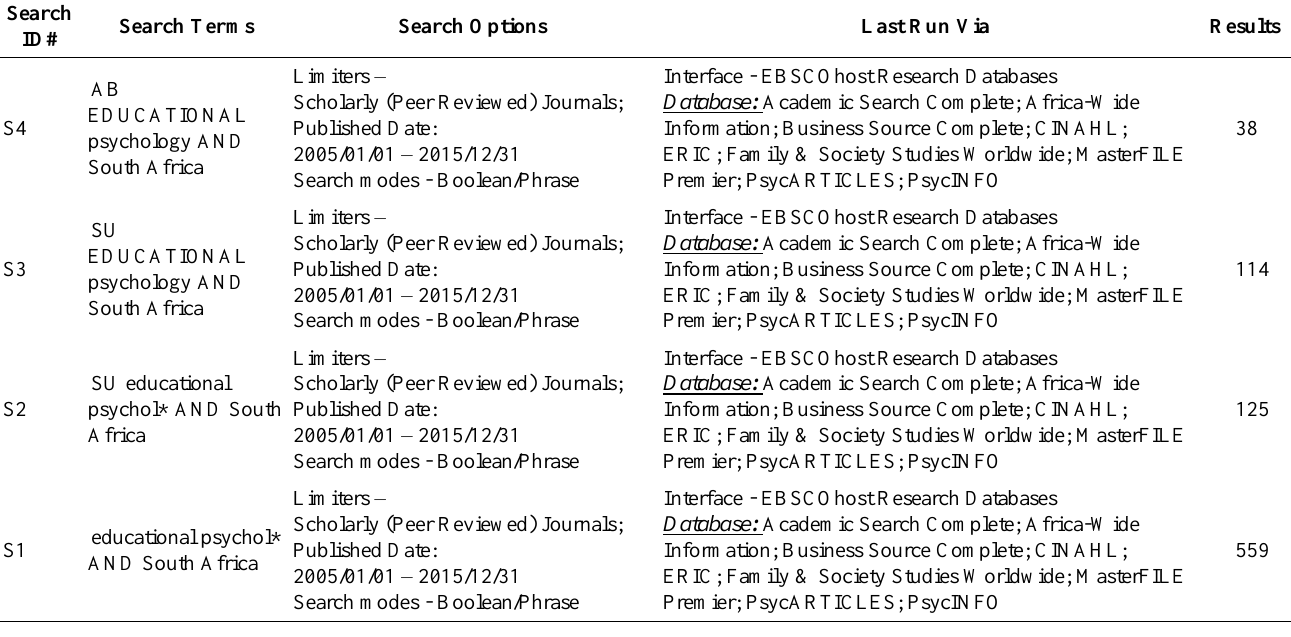
Results from the first advanced search on ‘Educational Psychology’ and ‘South Africa’ during the period 2005 –